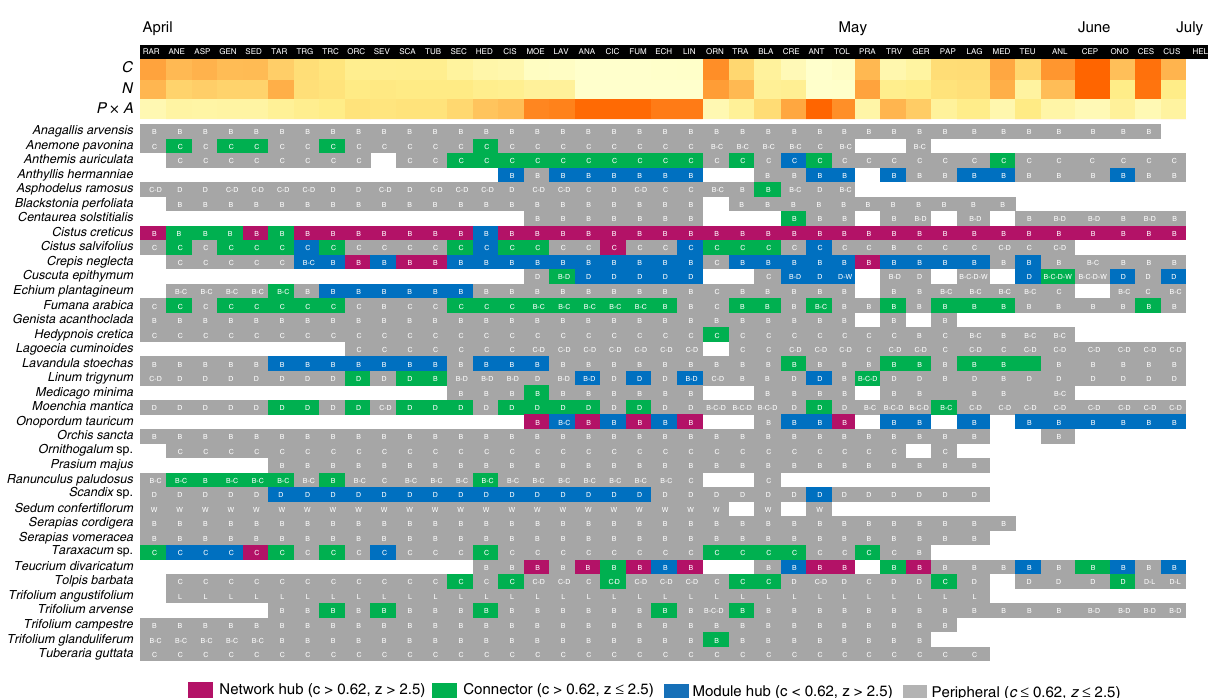
Fig. 2 The functional roles of the plant species in the phenonets of the community. Plant phenonets are shown in the top row (shaded in black) and are sorted temporally, so that plants with earlier start and shorter duration are ordered fi rst, from left to right. Months correspond to the start of fl owering only. For each phenonet, the values of three network properties are provided in a gradient colour scale: Connectance ( C ), Nestedness ( N ), and Network size ( P × A ). For each plant species (rows), the pollinator group with the highest number of species visiting the plant in each phenonet is also provided: Bees (B), Coleoptera (C), Diptera (D), Lepidoptera (L) and Wasps (W). White cells denote absence from the respective phenonet. For the phenonet